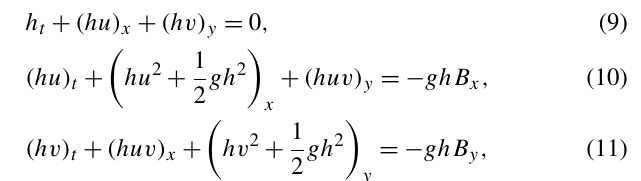
Figure 18. Response spectra at the surface with the different types of analyses.